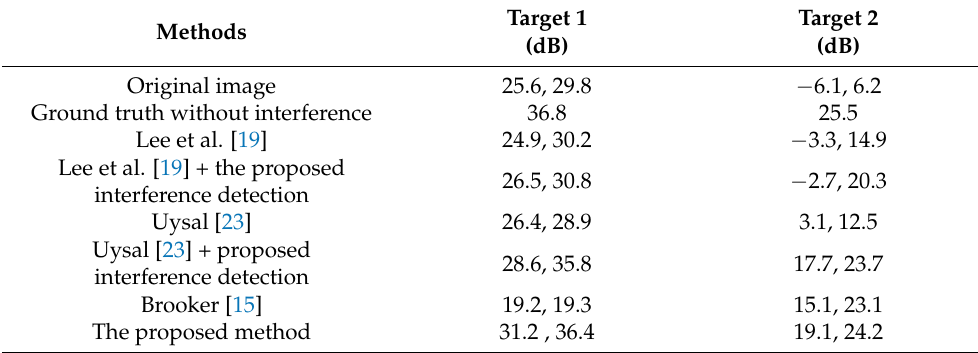
Table 2. Comparisons of PTINRs via simulations. The first number in each term is the result of stationary interference and the second number is the result of dynamic interference.